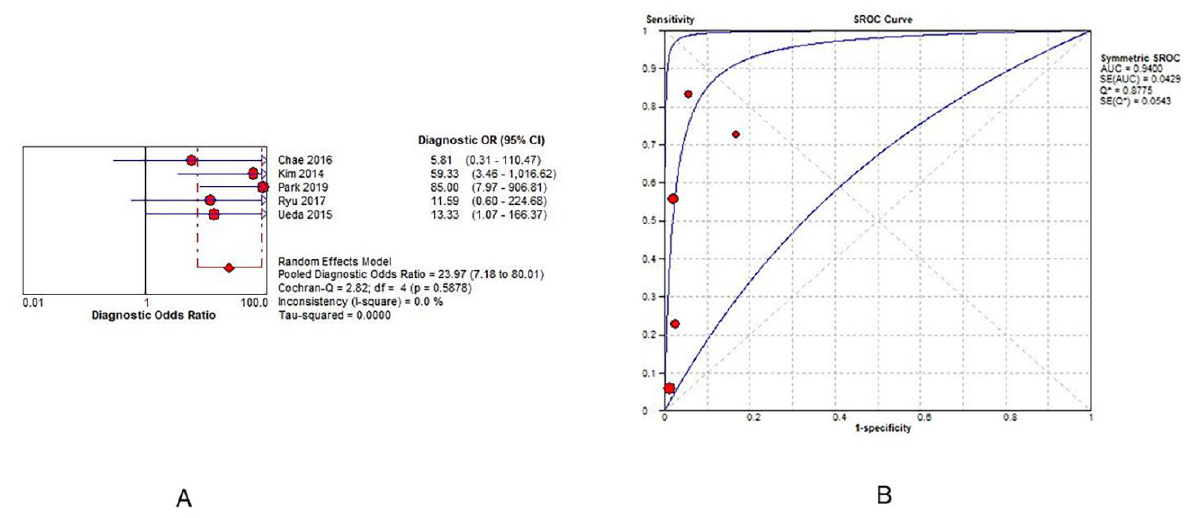
Figure 4. Prognostic accuracy of ONSD for a poor neurological outcome. ( A ): diagnostic odds ratio of ONSD in predicting a neurological outcome; ( B ): SROC curve of ONSD in predicting a neurological outcome. Abbreviations: CI = confidence interval; ONSD = optic nerve sheath diameter; SD = standard deviation; SROC = summary receiver-operating characteristic.